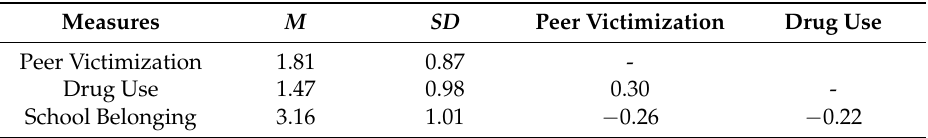
Table 1. Manifest Scale Bivariate Correlations, Means and Standard